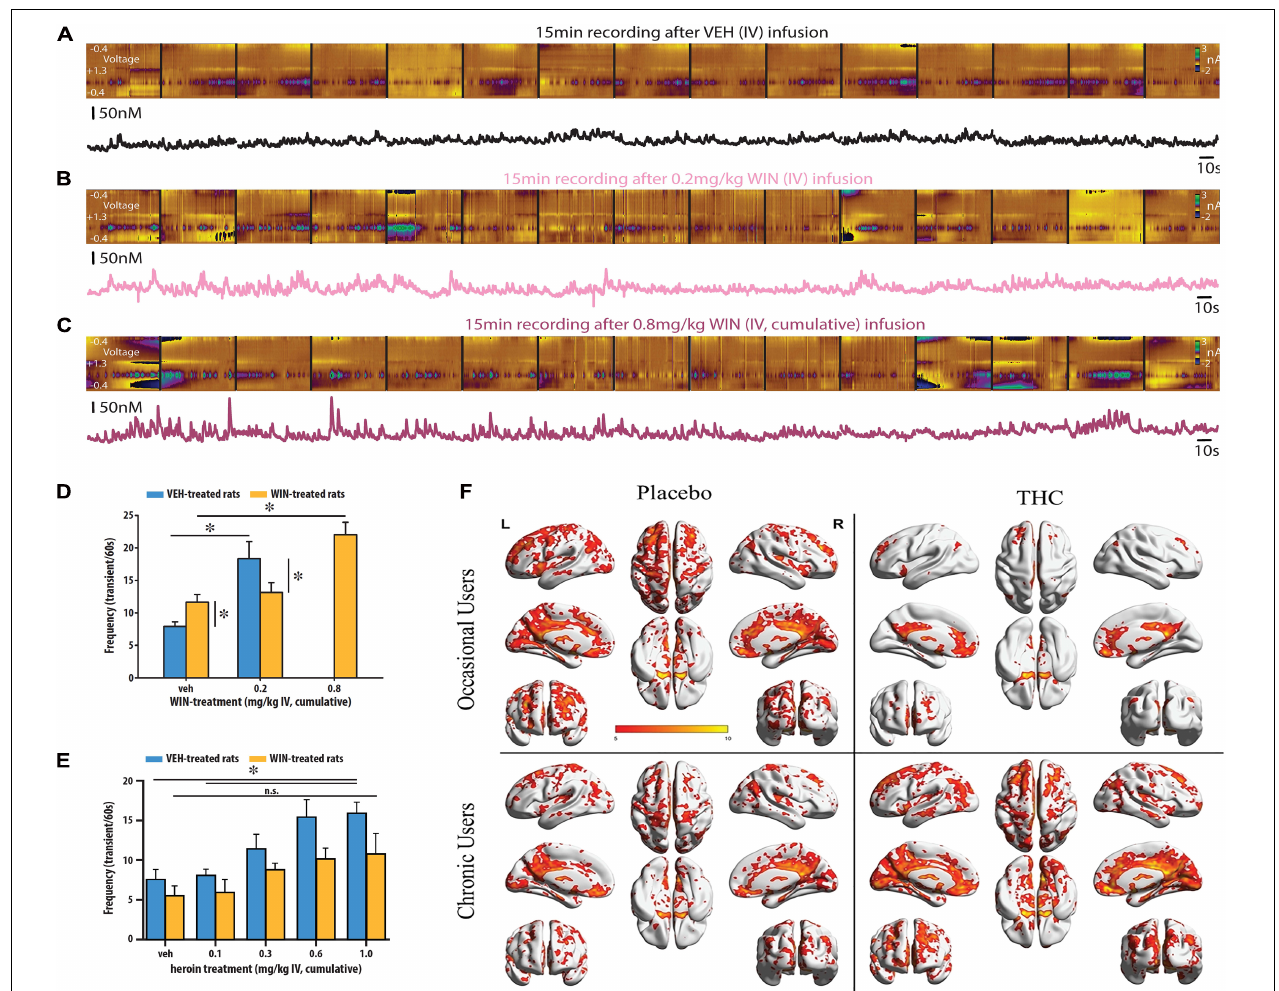
FIGURE 1 | Cannabinoids increase the frequency and amplitude of DA transients. Illustrative recording session in which the synthetic cannabinoid WIN was administered to an awake and freely moving rat. Stitched color plots [voltammetric current ( z -axis) × applied scan potential ( y -axis) × time ( x -axis)] are shown above corresponding DA concentration traces. Vehicle (A) , 0.2 mg/kg (B), and 0.8 mg/kg WIN (C) were administered in cumulative, ascending IV doses while FSCV measurements of DA release events occurred in the NAc shell in near real-time. Dose dependent increases in the frequency and amplitude of DA release events can be observed by the larger and more frequent green dots at a potential of +0.6 V in the color plots and the more frequent and pronounced transient peaks in the corresponding DA concentration traces. (D) WIN increased the frequency of DA release events but was less potent in chronically WIN-treated rats. A higher dose of WIN (0.8 vs. 0.2 mg/kg IV) was required to produce a significant increase in DA release vs. vehicle treated rats. (E) Heroin dose-dependently increased the frequency of DA release events but was less effective in chronically WIN-treated rats. In WIN-treated rats, heroin did not significantly increase the frequency of DA transients vs. vehicle at any dose tested. Republished from Gomez et al. (2020). (F) NAc–related functional connectivity in the left hemispheres. Shown are thresholded Z –score maps of functional connectivity for each group and each condition. Smoked THC reduced functional connectivity between the NAc and broad areas of the